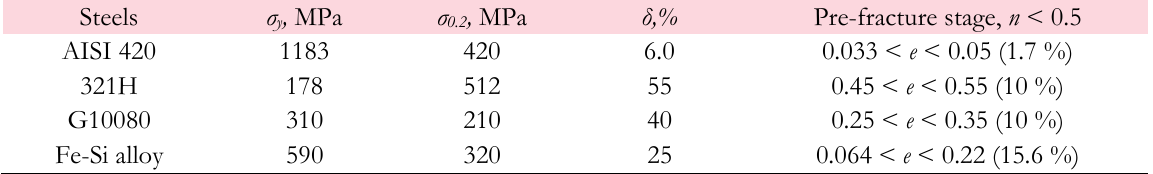
Table 2: Mechanical properties of the samples and the length of the pre-fracture stage.